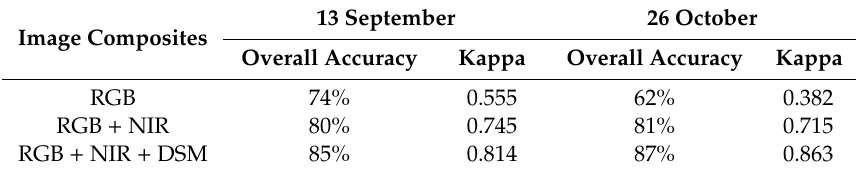
Table 4. Accuracy assessment results for three image composites at the Xingang sampling